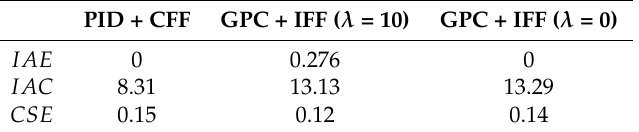
Table 1. Performance indexes for different configurations of PID (Proportional - Integral - Derivative) and GPC (Generalized Predictive Control) feedforward control schemes. IAE , Integrated Absolute Error; IAC , Integrated Absolute Control; CSE , Control System Effort. PID + CFF GPC + IFF ( λ =